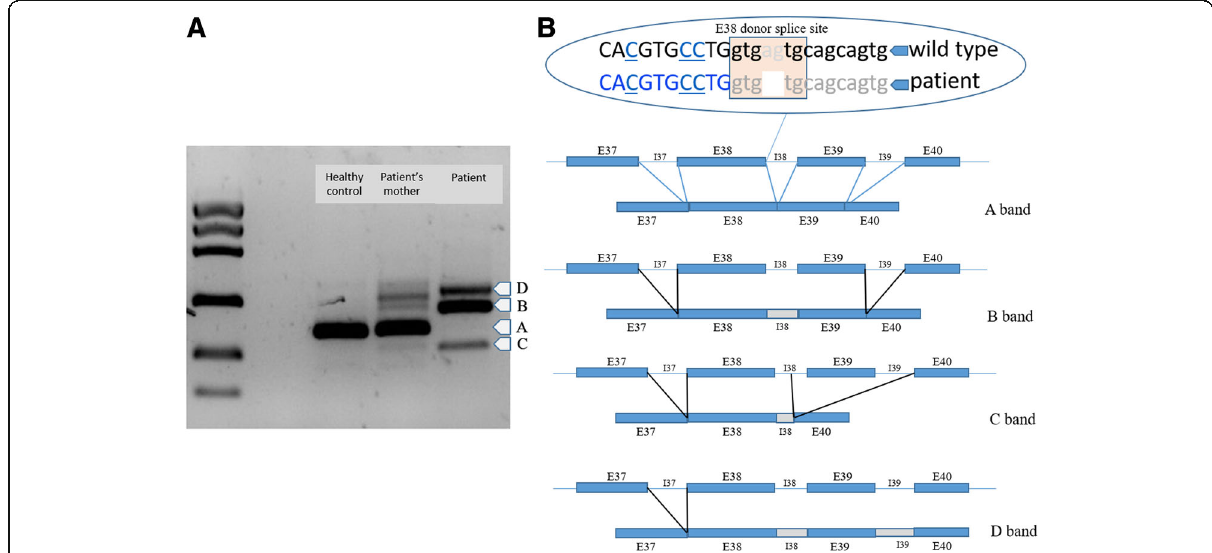
Fig. 3 a Electrophoresis of cDNAs from the FLNA genes of a healthy control, the patient ’ s mother (heterozygous for the FLNA variant), and the patient (hemizygous). b Different FLNA splicing isoforms found in the patient: the A-band corresponds to wild type cDNA, the B-band includes intron 38; the C-band includes a portion of intron 38 but not exon 39; and the D-band includes introns 38 and